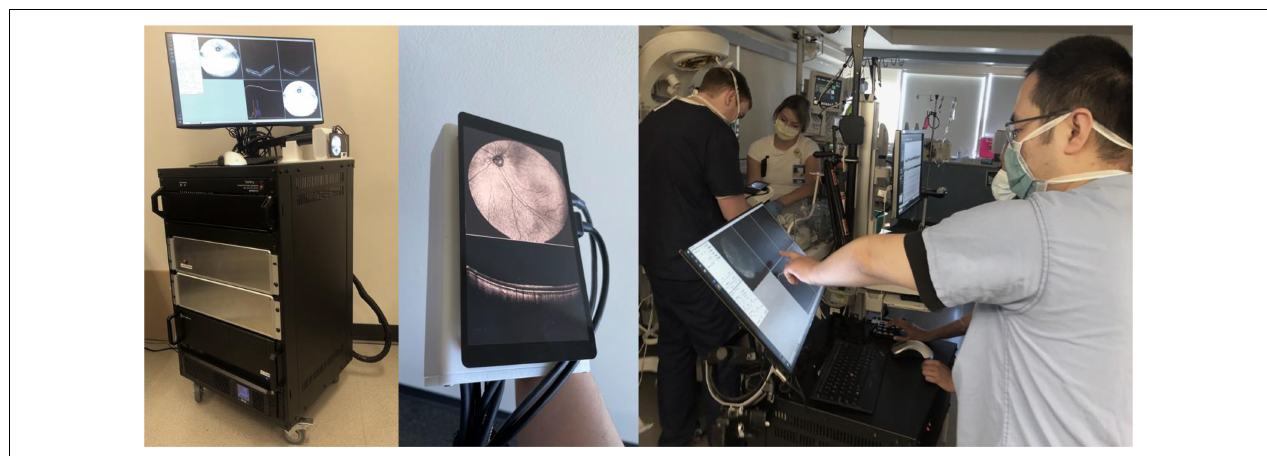
FIGURE 1 | Handheld, SS-OCT device. From left: portable prototype device, imaging probe with real-time en face display, and process of obtaining OCT volumes of an infant in the